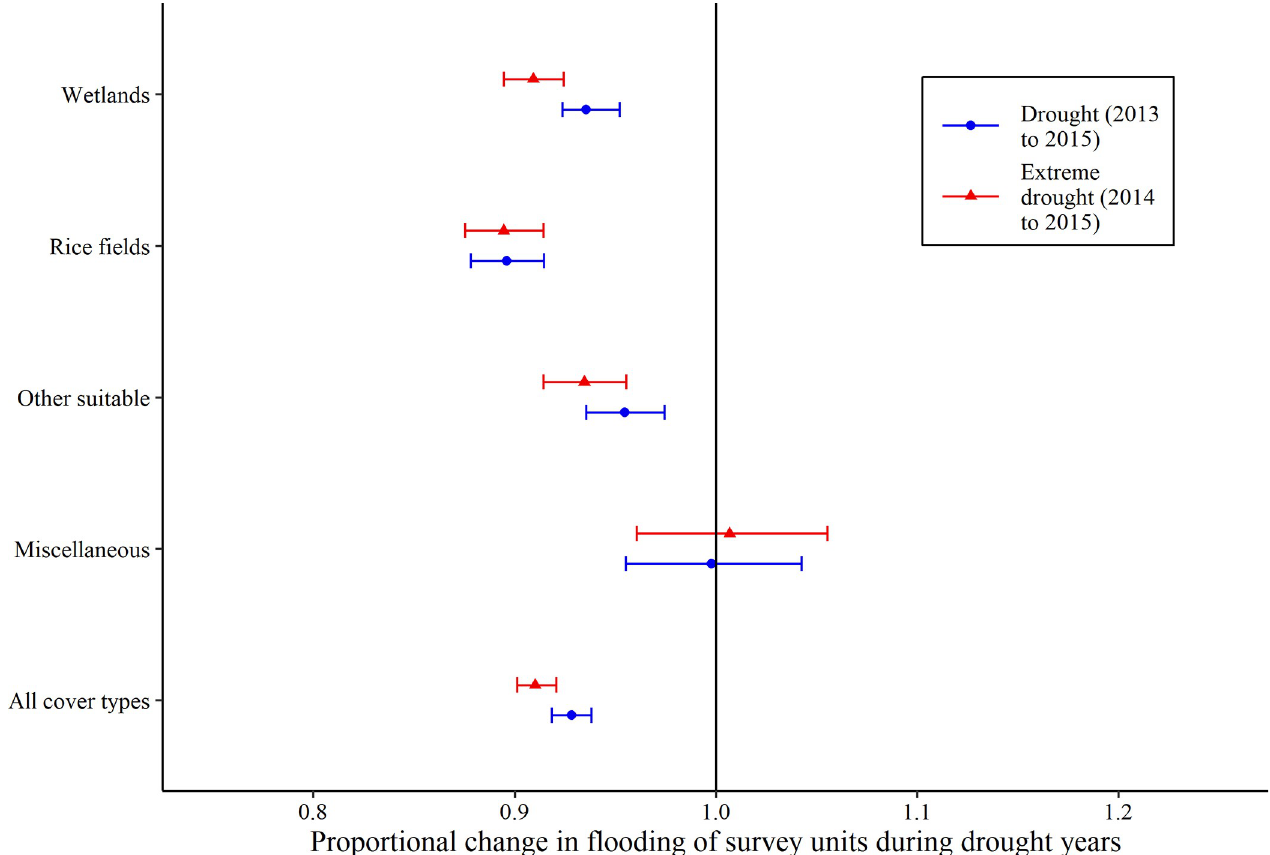
Fig 5. Estimated proportional change in flooding of survey units during drought years. Results from generalized linear mixed models of the proportion flooded of shorebird survey units from 2011 to 2016 in the Central Valley California, USA. Plots for each land cover type show the estimated change in the annual proportion flooded of survey units from the 3-year drought (2013–2015) model or 2-year extreme drought (2014–2015) model. The solid black line represents the proportion flooded of survey units during a non-drought year. See Methods for details on the types of land cover that composed the “other suitable” and “miscellaneous” land cover